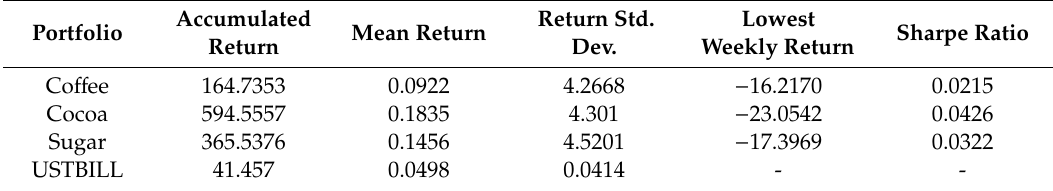
Table 3. Performance summary of the simulated portfolios with the buy-and-hold strategy in the three commodities of interest (figures in %, with the exception of the Sharpe ratio).